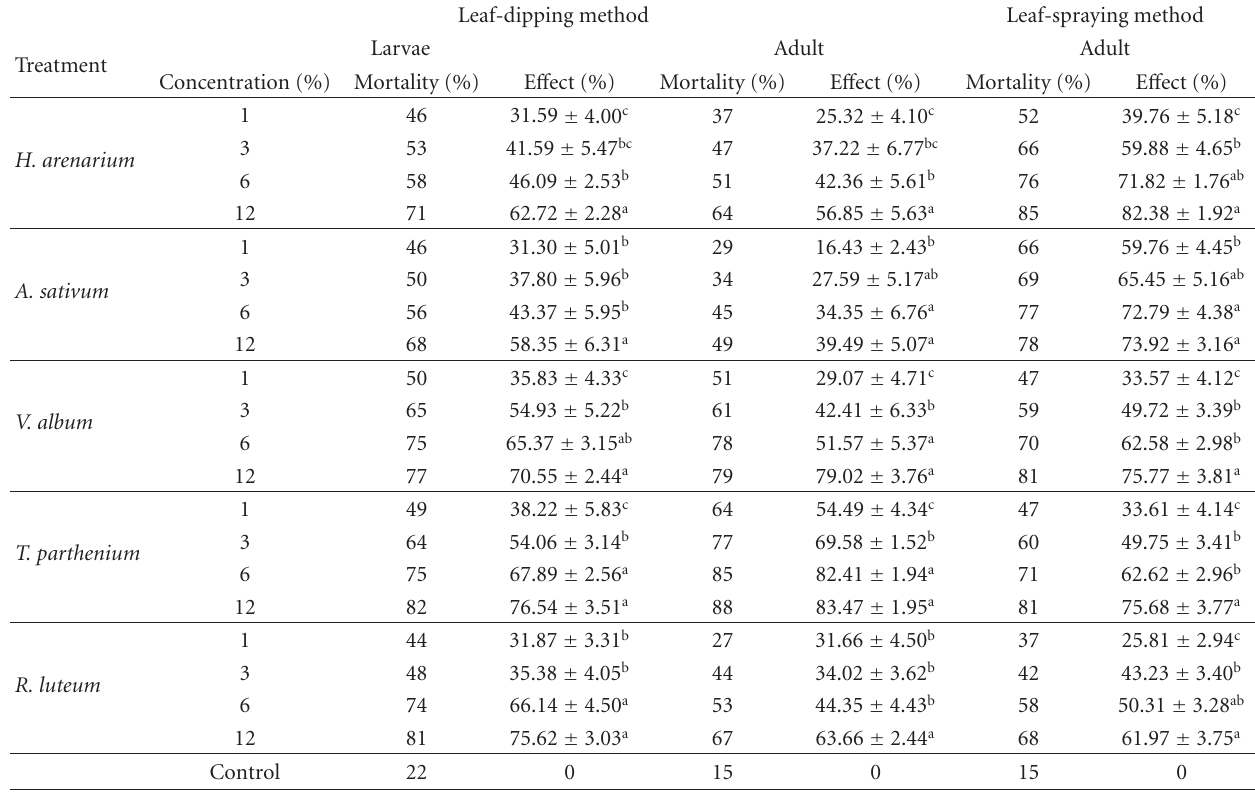
Table 1: E ff ect (mean ± SE) and mortality (%) of extracts obtained from di ff erent five plants on T. urticae . Leaf-dipping method Leaf-spraying method Larvae Adult Treatment Concentration (%) Mortality